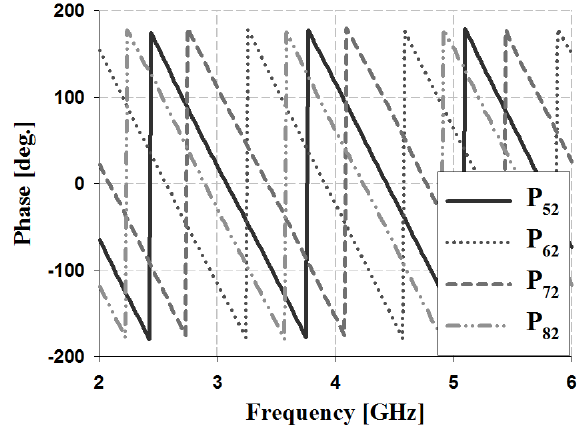
Figure 20. Measurement analysis of phase for input Port 2.